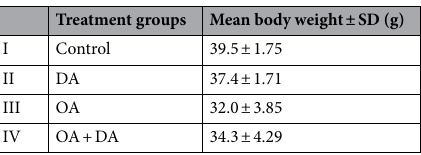
Table 2. Mean body weights (g) ± SD of Swiss Albino mice as per the treatment groups at the end of 4 weeks of experimental